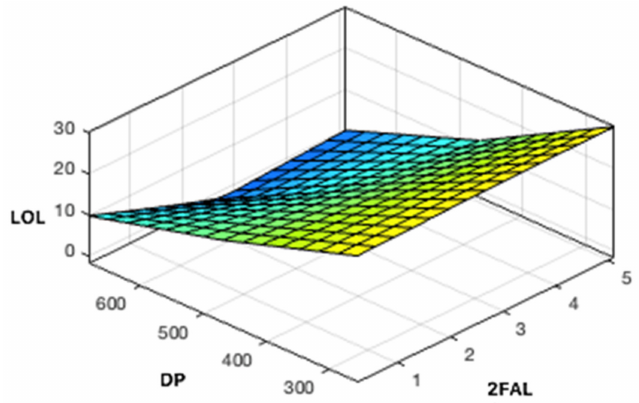
Figure 9. Proposed ANFIS Surface